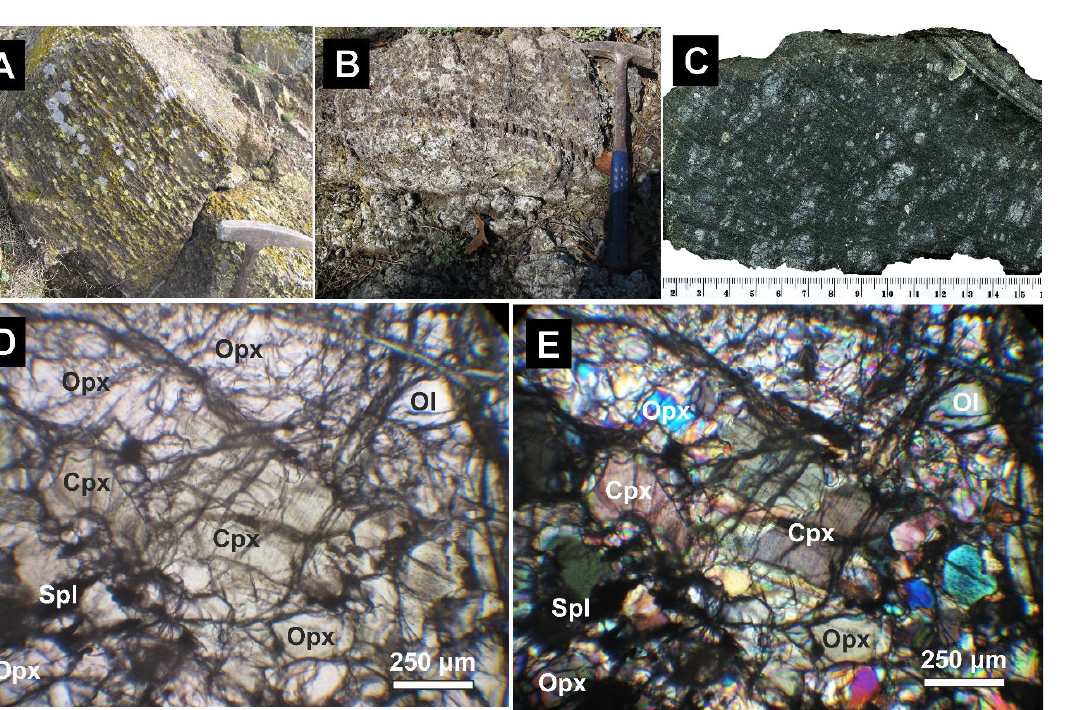
Figure 4. Macroscopic and PL microscopic images of lherzolites ( A , D , E –s. P8A; B –s. P7; C –s. P2). ( A,B ) Macroscopic layering by alternation of softer serpentinized Ol ‐ rich layers with Px ‐ rich ones. ( A , B ) Macroscopic layering by alternation of softer serpentinized Ol-rich layers with Px-rich ones. ( C ) Cut surface with pale Px ‐ rich stripes. ( D,E ) Cpx aggregates separating flattened Opx porphy ‐ roclasts in slightly serpentinized Ol matrix. Picture D at II P; E at X P. ( C ) Cut surface with pale Px-rich stripes. ( D , E ) Cpx aggregates separating flattened Opx porphyro- clasts in slightly serpentinized Ol matrix. Picture ( D ) at II P; ( E ) at X